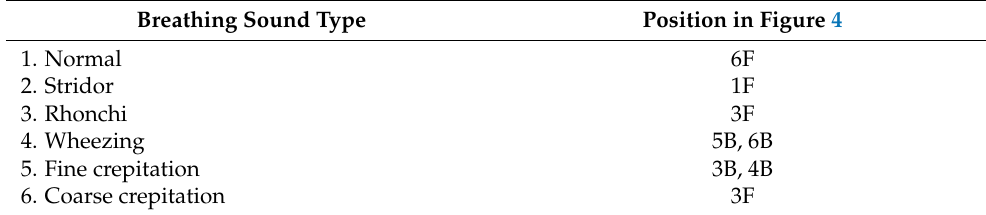
Table 1. The relationship between breathing sound types and positions from experts’